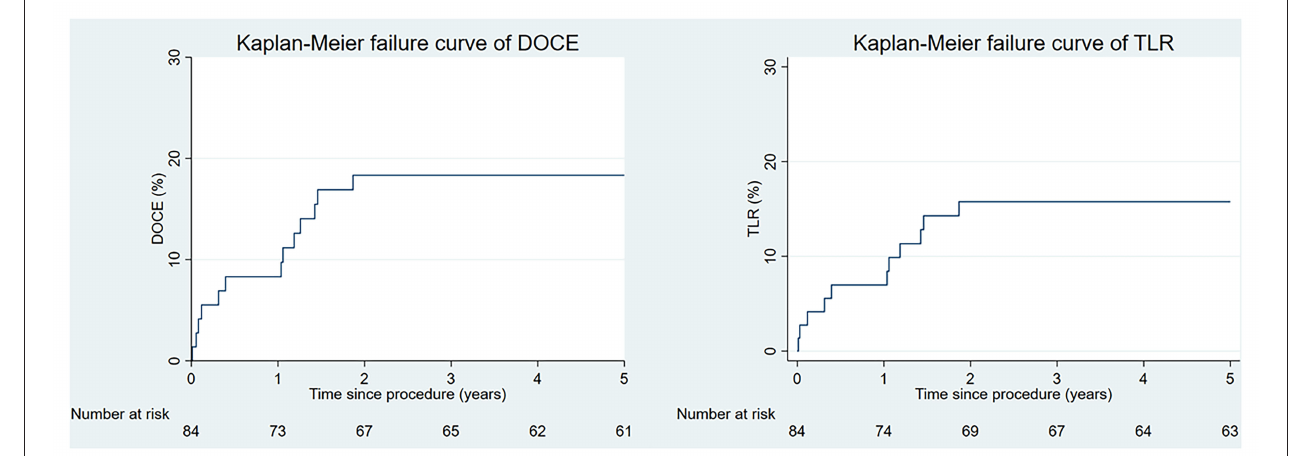
FIGURE 1 | The Kaplan–Meier curves for the device-oriented composite endpoint (DoCE) and target lesion revascularization (TLR) over time.